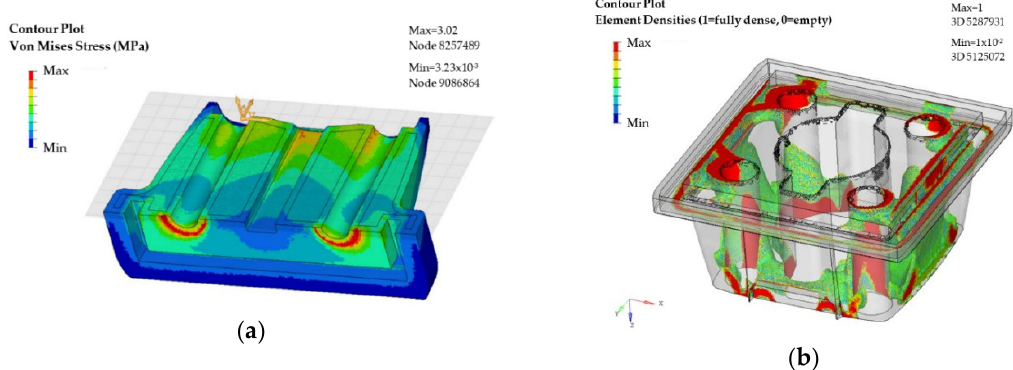
Figure 11. Case study part (support): ( a ) Von Mises stress focused on fixations; and ( b ) results of topological optimization.